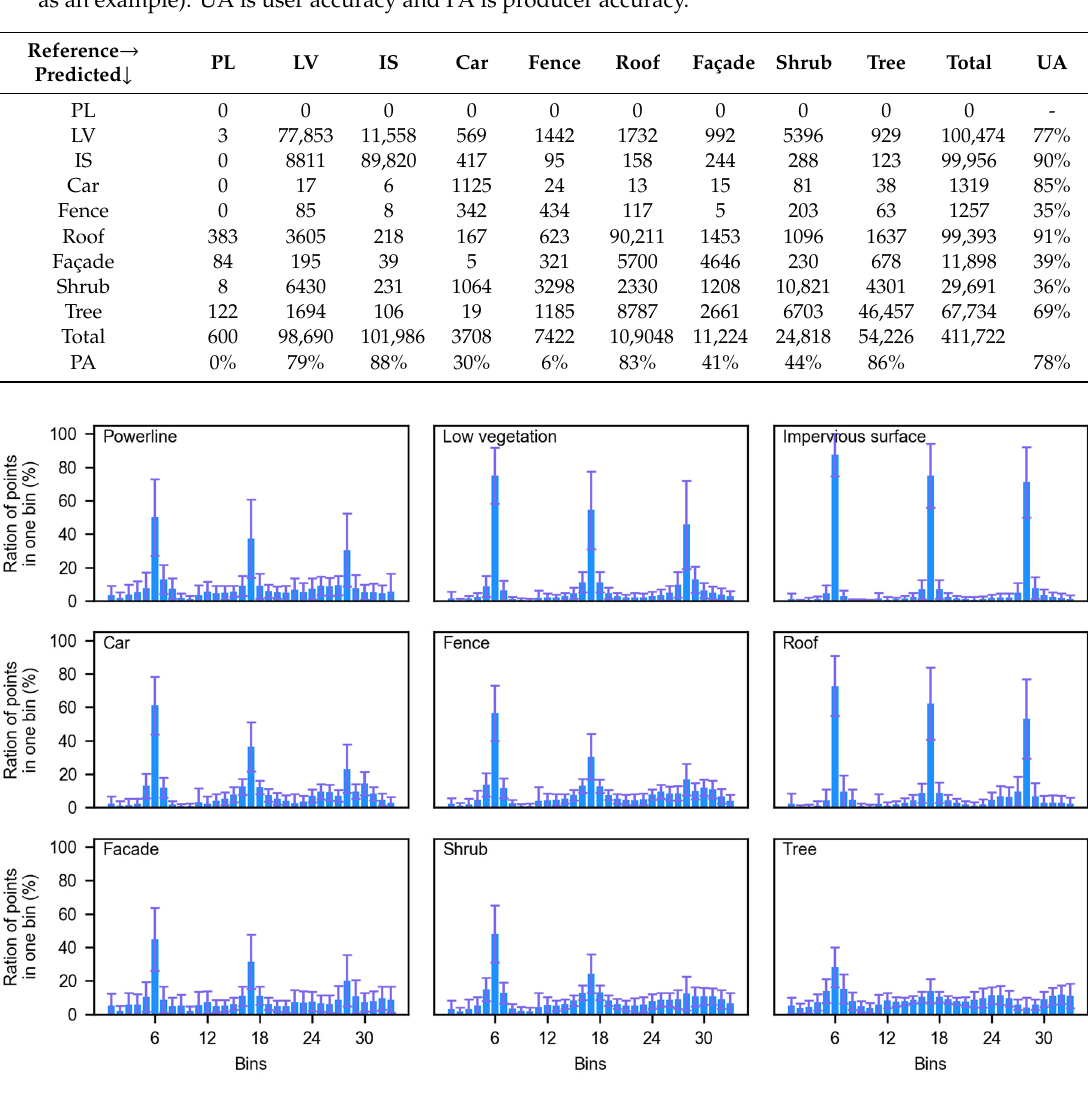
Table 1. F1 score of the proposed method (%).